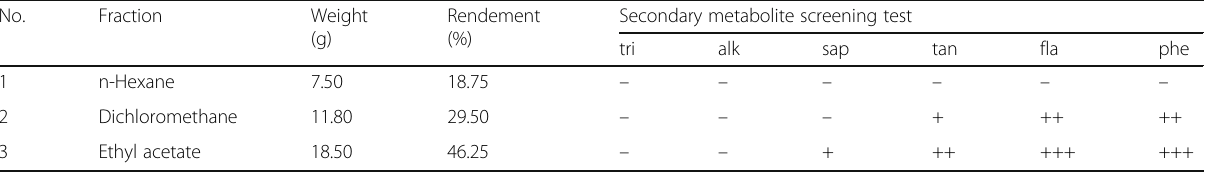
Table 1 Profile fraction of the Malaka flesh extracts on quantitative and qualitative records No.